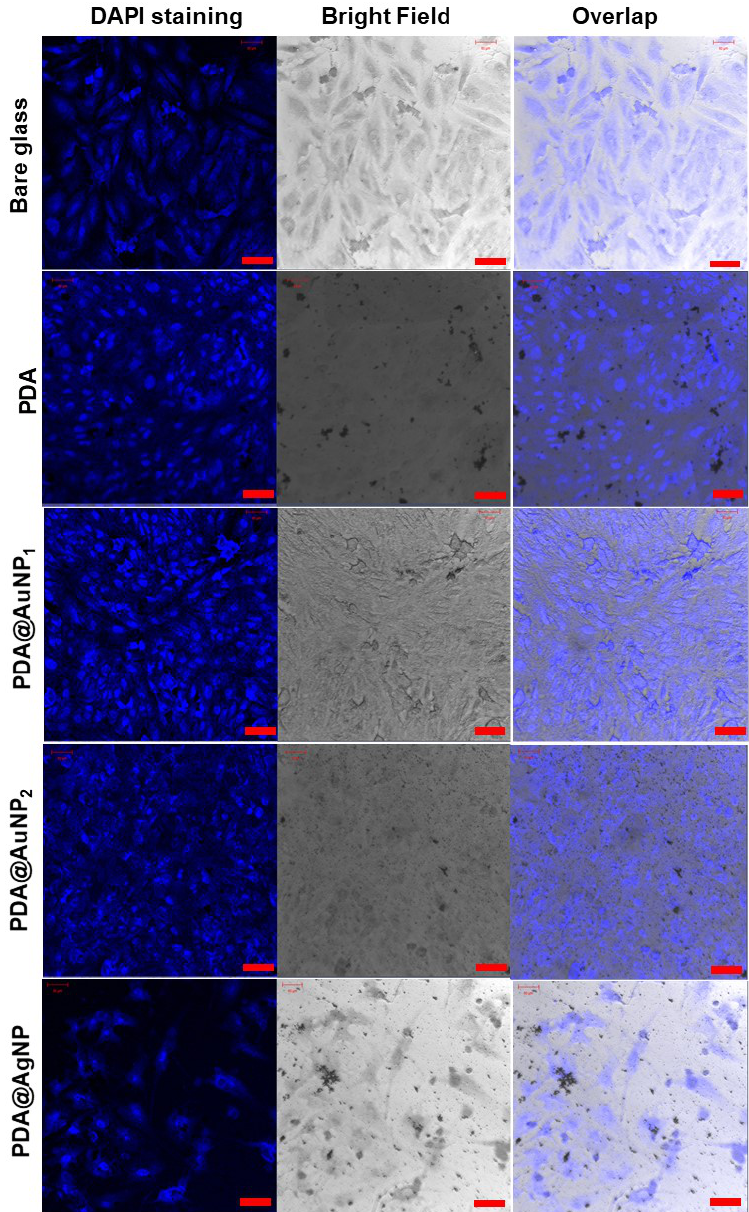
Figure 4. Confocal microscope images of CaCO2 cells on different surfaces at 20× magnification. Scale bars are 50 µm.